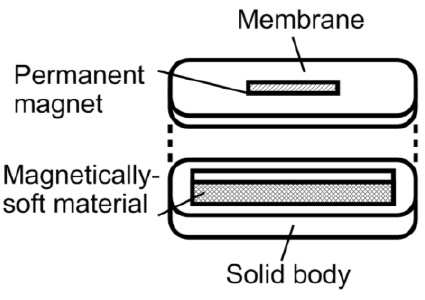
Figure 1. A diagram illustrating the design of the magneto-harmonic pressure